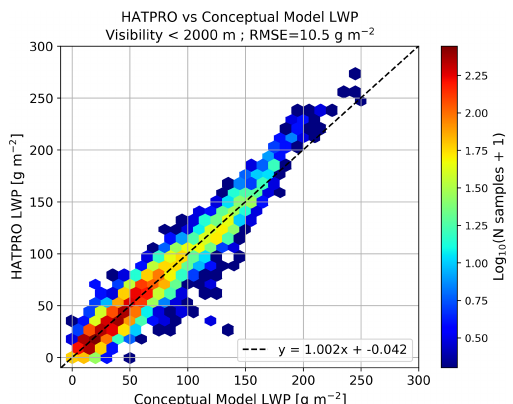
Figure 6. Two-dimensional histogram comparing HATPRO and conceptual model LWP values, for data retrieved when visibility is less than 2000m. Conceptual model LWP is calculated using fog CTH, fog LWC at the surface derived from visibility, surface tem- perature, surface pressure, and the adiabaticity parametrization of Eq. (7). Under these conditions, the conceptual model predicts LWP with an RMSE of 10.5gm − 2 and an almost perfect linear relation-